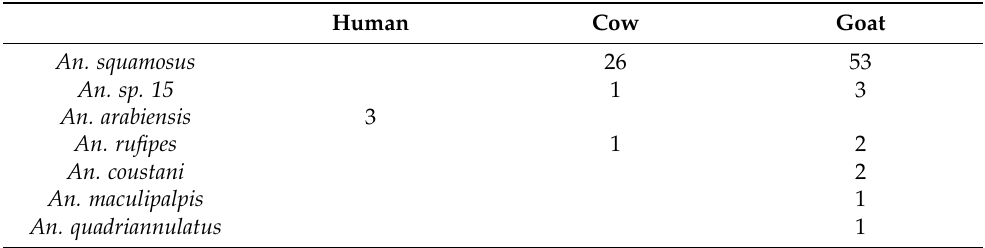
Table 3. Identification of blood meals using 12S rRNA